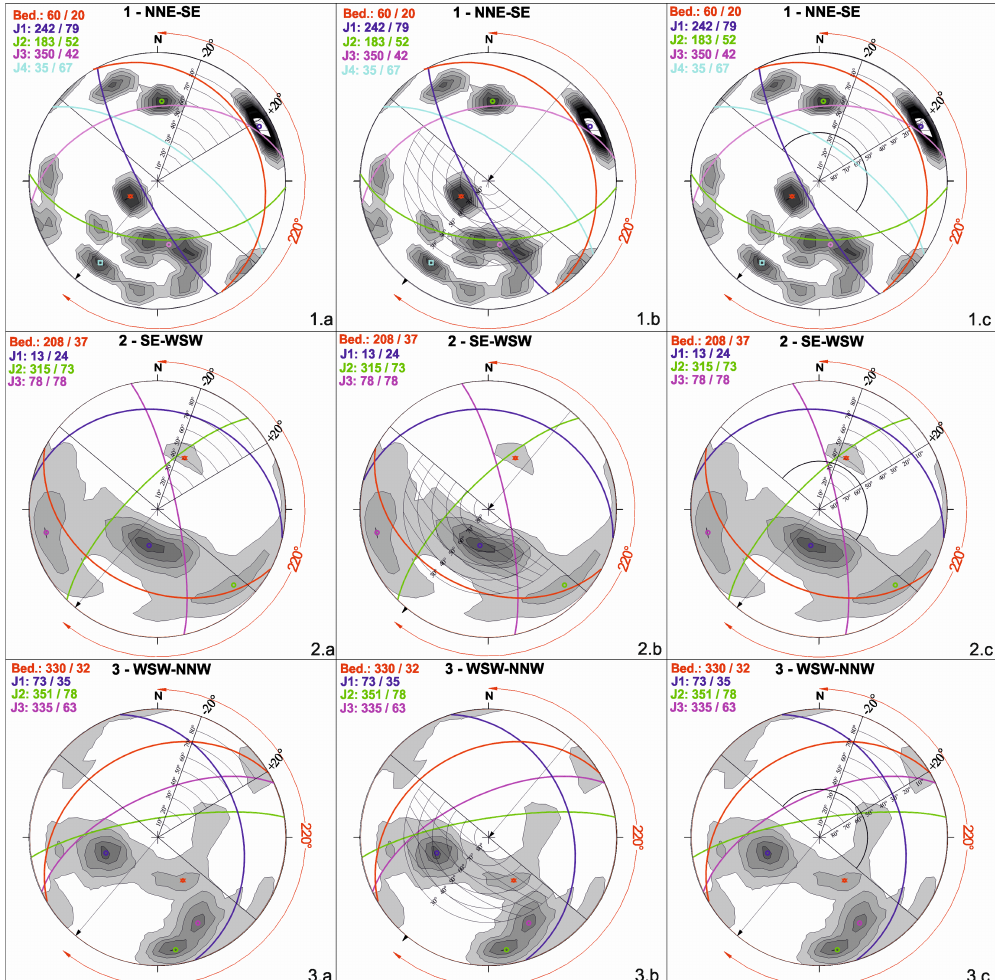
Fig. 8. Matheson’s test, referenced to a slope dip direction of 220 ◦ and applied to structural domains 1 to 3 (rows 1, 2 and 3) and to mechanisms of instability for plane sliding (column a), wedge sliding (column b) and toppling (column c).